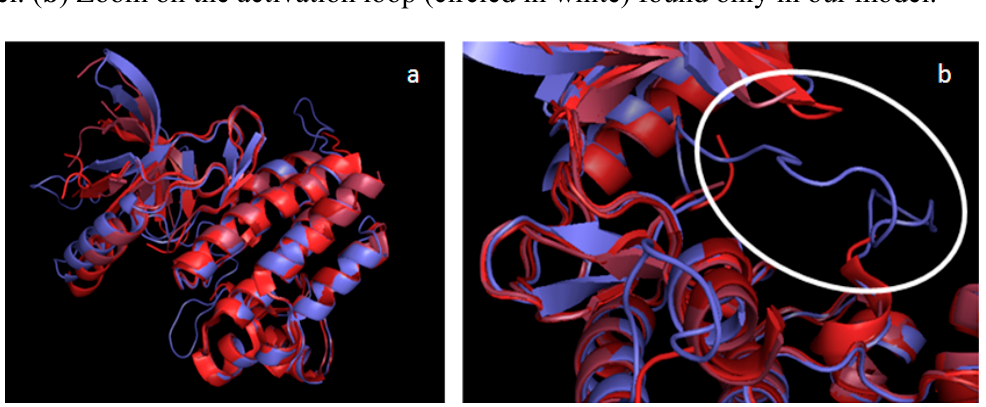
Figure 2. Alignment of all Tyro-3 structures from PDB with our Tyro-3 DFG-Asp in model. PDB structure of Tyro-3 in different shades of red (PDB ID 3QUP in TV red; PDB ID 4FF8 in firebrick; PDB ID 4FEQ in raspberry); our Tyro-3 DFG-Asp in model, in slate blue (all colors from PyMOL). ( a ) Superimposition of Tyro-3 crystal structures with our Tyro-3 DFG-Asp in model. ( b ) Zoom on the activation loop (circled in white) found only in our